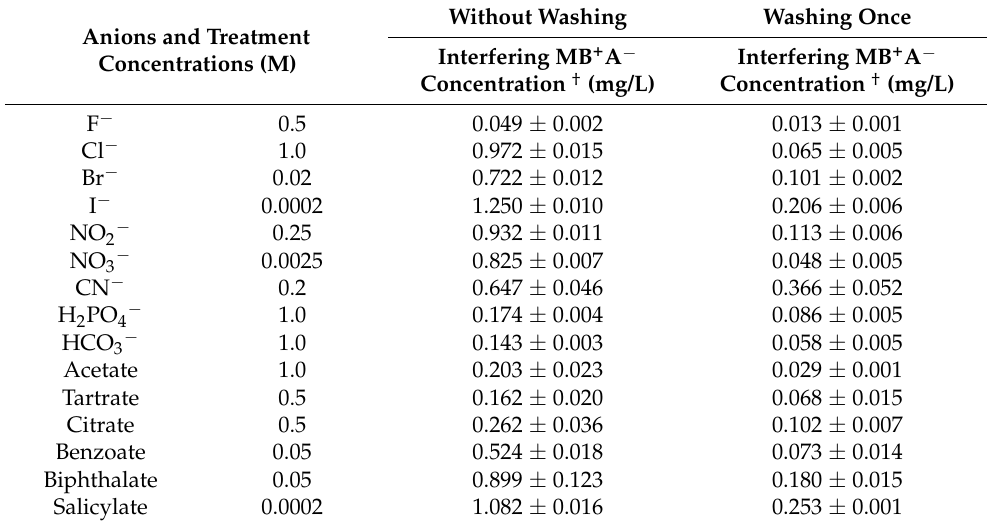
Table 1. Washing efficiency of deionized water on the anionic interferences in MIBK-DCE extraction. Without Washing Washing Once Anions and Treatment Interfering MB + A − Interfering MB + A − Concentrations (M) Concentration † (mg/L) Concentration † (mg/L) F − 0.5 0.049 ±